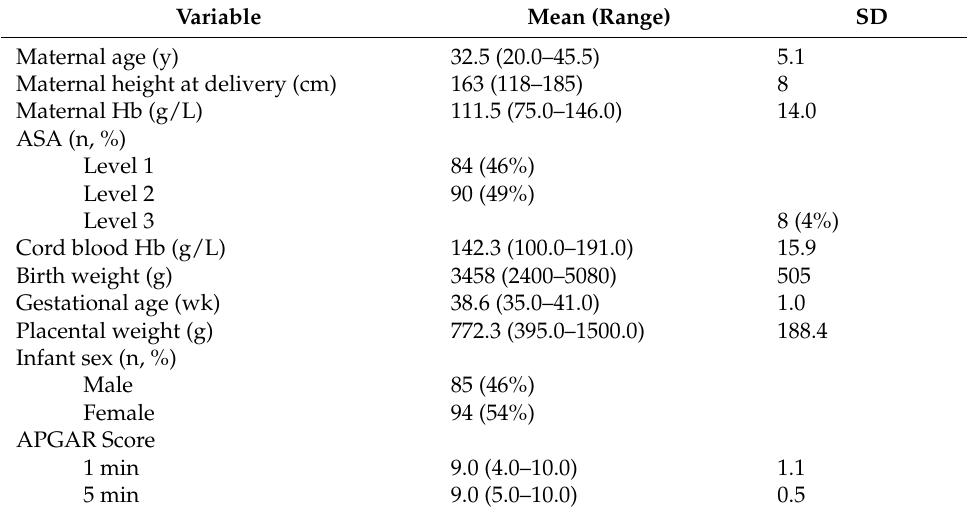
Table 1. Study population characteristics ( n =